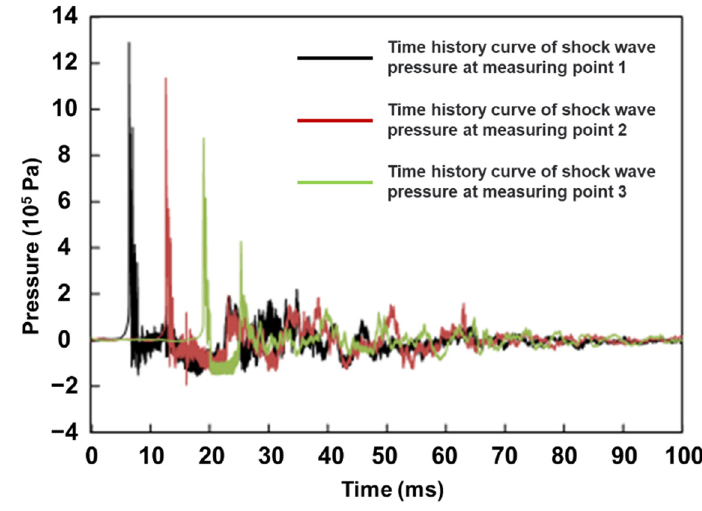
Figure 2. Time history curve of shock wave pressure.